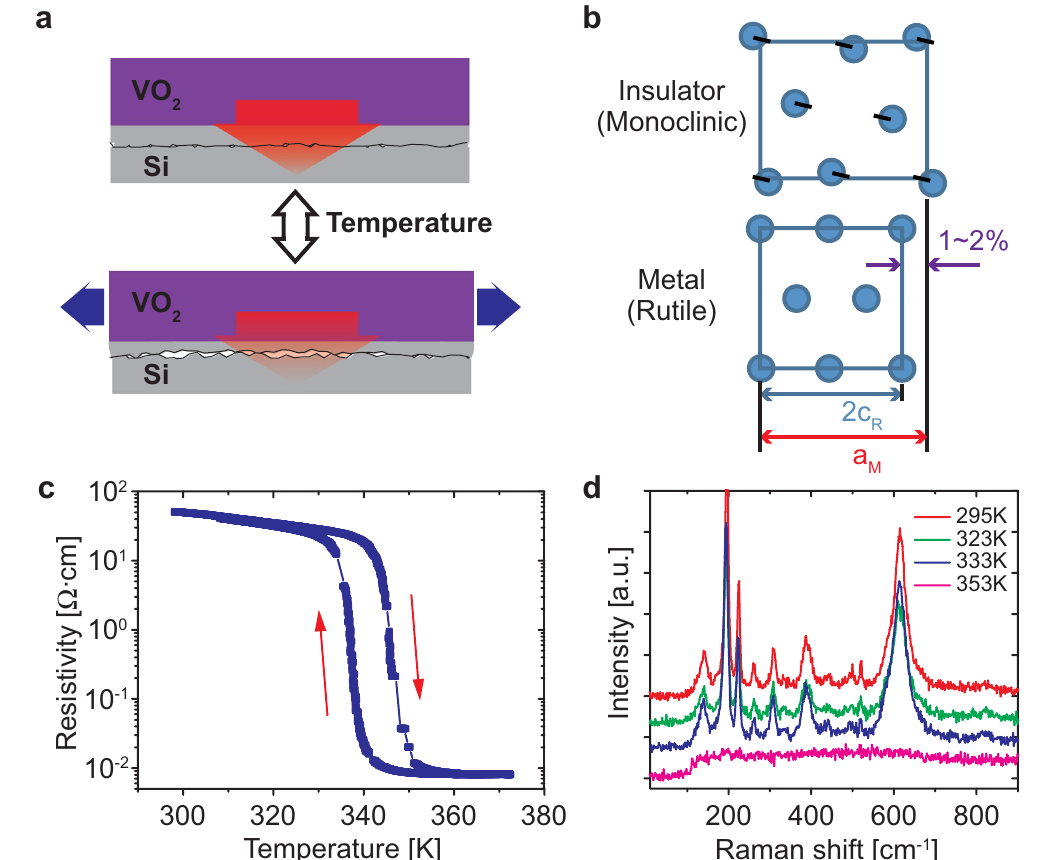
Figure 1. Concept of the nanostructured phase transformation and as-grown VO 2 film properties. ( a ) Schematic of the nanostructured phase transformation with a nanogap, showing contact pressure and area modulated by the phase transition strain. ( b ) Illustration of the lattice structure change of VO 2 across the phase transition between the insulating and metallic phases. In the schematics, the cyan circle indicates vanadium atom, and oxygen atoms are omitted for clarity. ( c ) Semi-log plot of resistivity of the VO 2 film as a function of temperature during the heating and cooling process. ( d ) Raman spectra of the VO 2 film at different temperatures showing the phase transition between 333 and 353